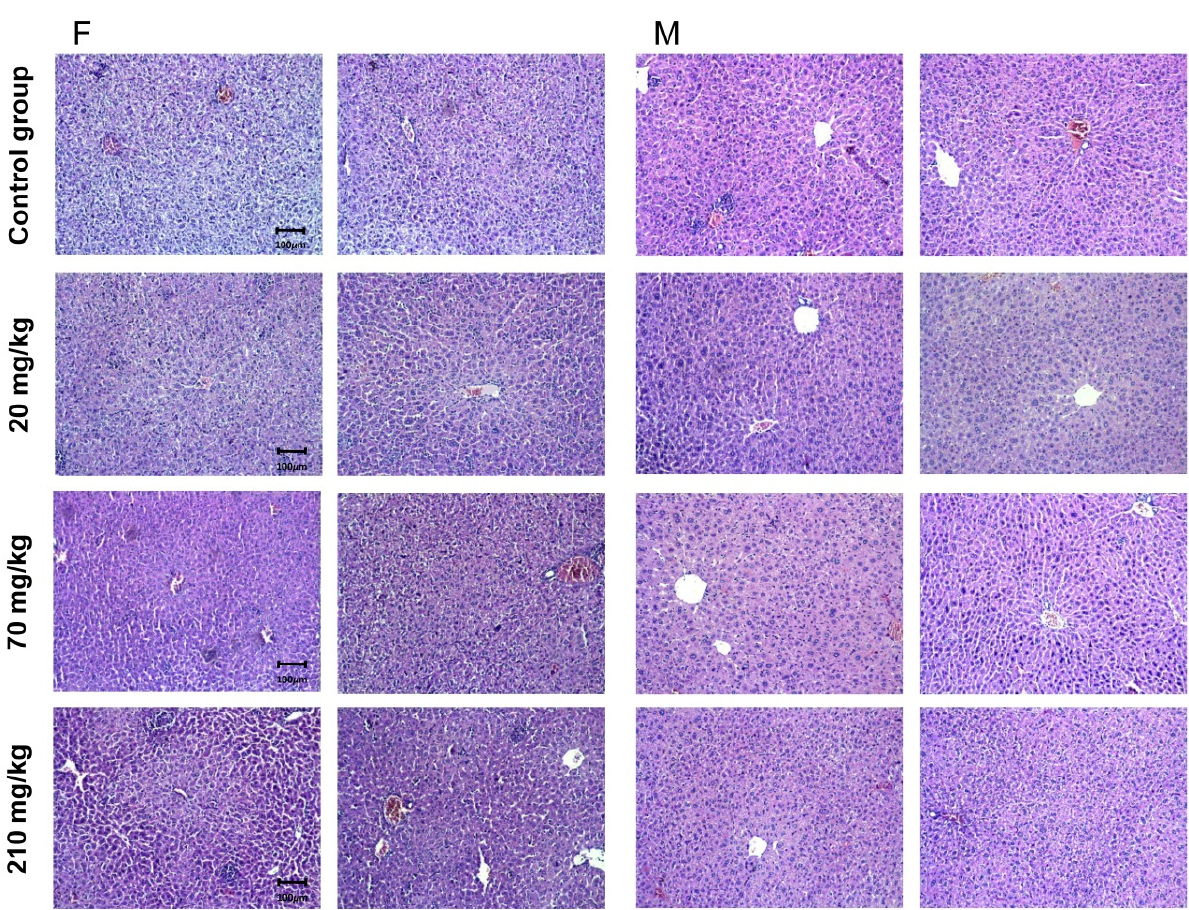
Figure 5. Pathomorphological findings of mice liver tissue specimens after oral administration of G. urbanum EtOAc-AP extract for 14 days. The four groups of animals with preparations from two animals of each sex and group are presented in the picture. Three groups of each sex were administered a different dose of the extract—20, 70 or 210 mg/kg. The control group received no extract. Legend: F—female animals; M—male animals; field magnification – 200x.